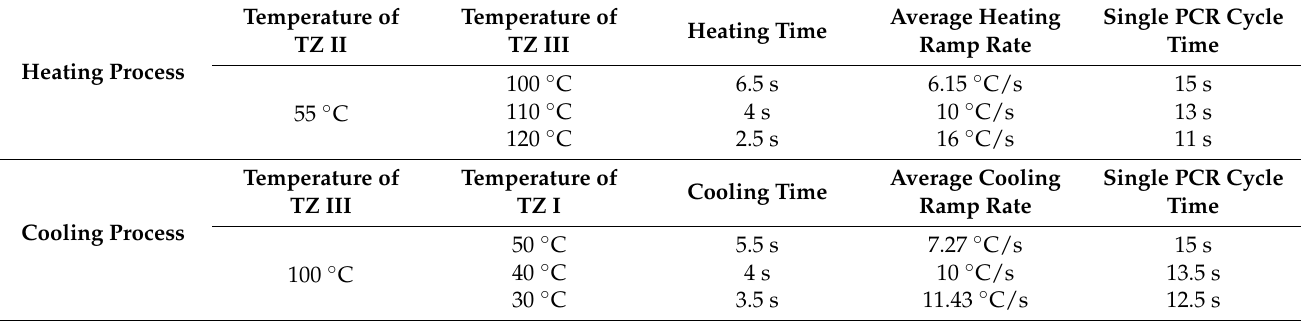
Table 3. Thermal performance of solution at different temperature overshoots in TZ III and TZ